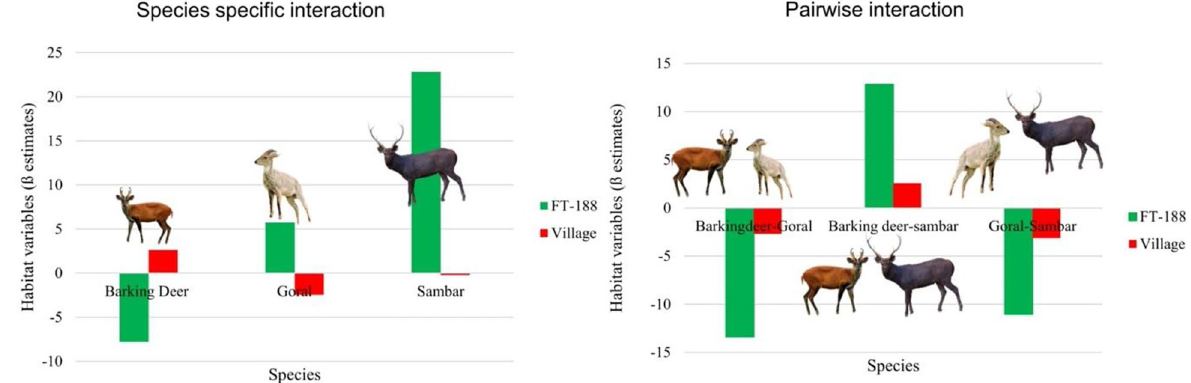
Figure 1. Species-specific and pair-wise interaction showing the influence of top model covariates (Green bars-forest type (West Himalayan Sub-alpine birch/fir Forest (FT 188) and Red bars distance to a village) on the occupancy of barking deer, goral and sambar in Uttarkashi. Microsoft office (MS version 2016) was used to create